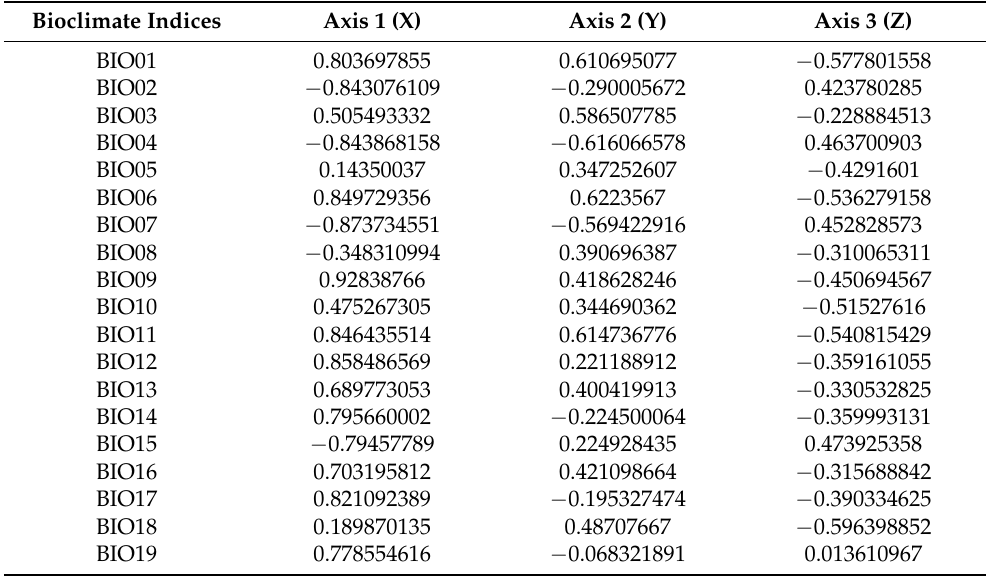
Table 4. The correlation between values of each bioclimate and values obtained in the